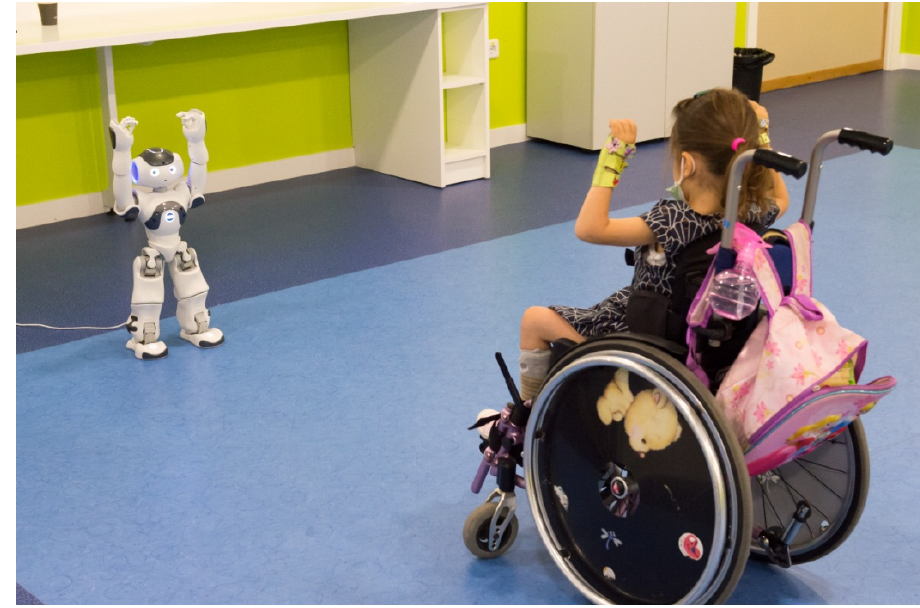
Figure 2. Patient during an experimental session with humanoid robot Robic.